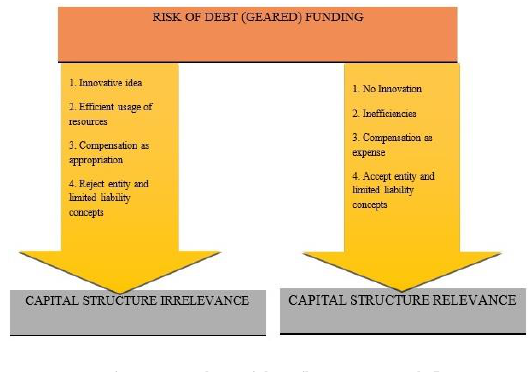
Figure 1. The Risk/Vibrancy